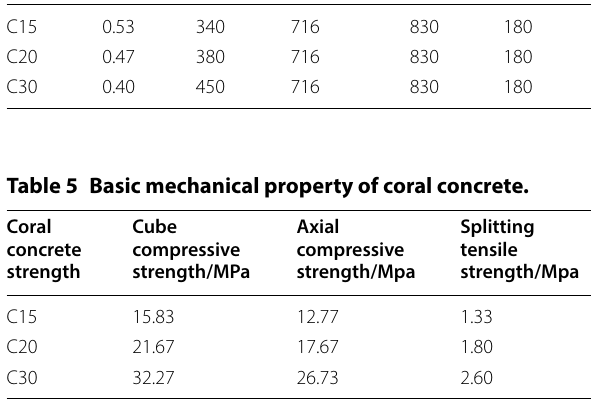
the downward displacement of free-end coral concrete caused by the deformation of the plate as close as pos- sible to the free end of the BFRP bar. The difference between them is the relative slip value of the free end of the BFRP bars. In order to avoid impact damage of the BFRP bar specimen, loading rate was intentionally kept uniform as V F 0.03 d 2 (V F is the loading rate, KN/min; d = is the nominal diameter of the BFRP bar, mm), the loads and the corresponding reading of the two electronic dial gauges are recorded during the pull test, and the test phe- nomenon were observed. When the BFRP bars were bro- ken, the coral concrete split or the free end slip exceeded 40 mm, the test was terminated. The shear stress on the bond interface between BFRP bars and coral concrete is defined as the bond stress (Gao et al. 2000). The bond stress changes along the length of BFRP bars. This paper calculates the average bond stress by using formula (1).